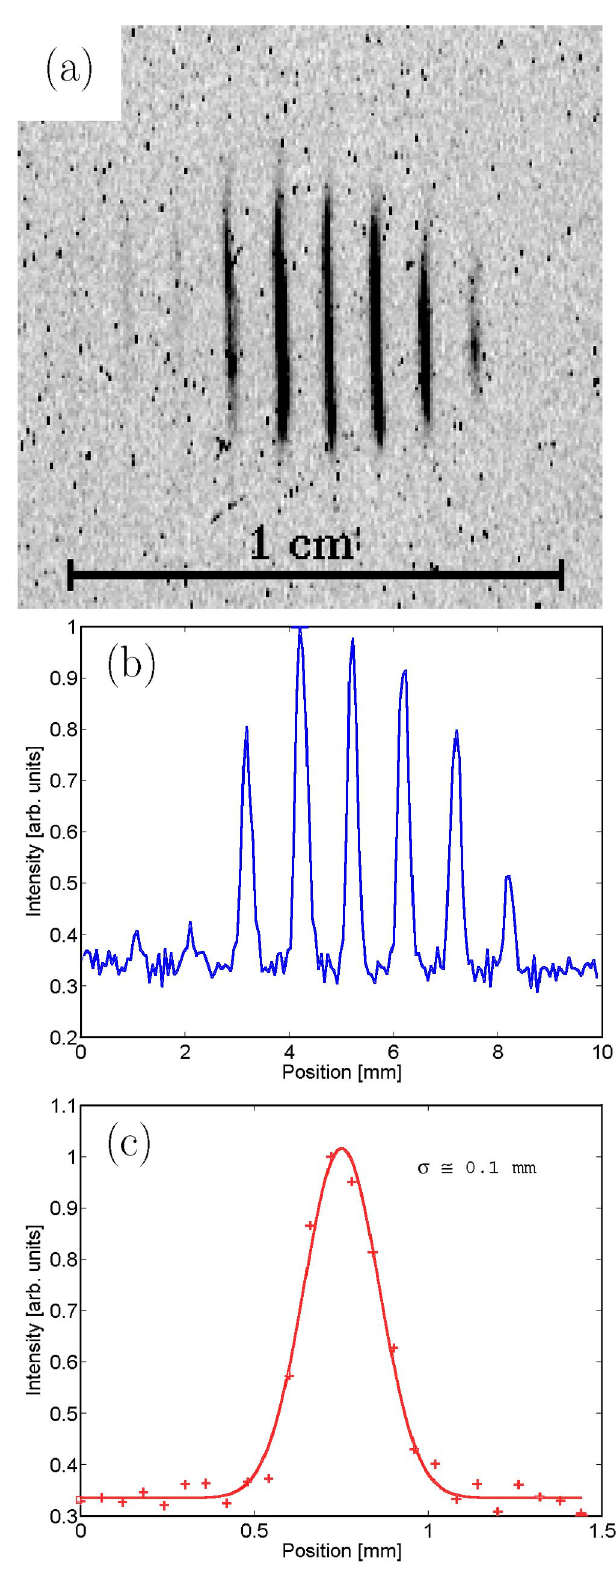
FIG. 3. (Color) (a) Image of an 8 nC beam going through the slit mask located 384 mm upstream, (b) density projection, and (c) Gaussian fit of the beamlet of highest